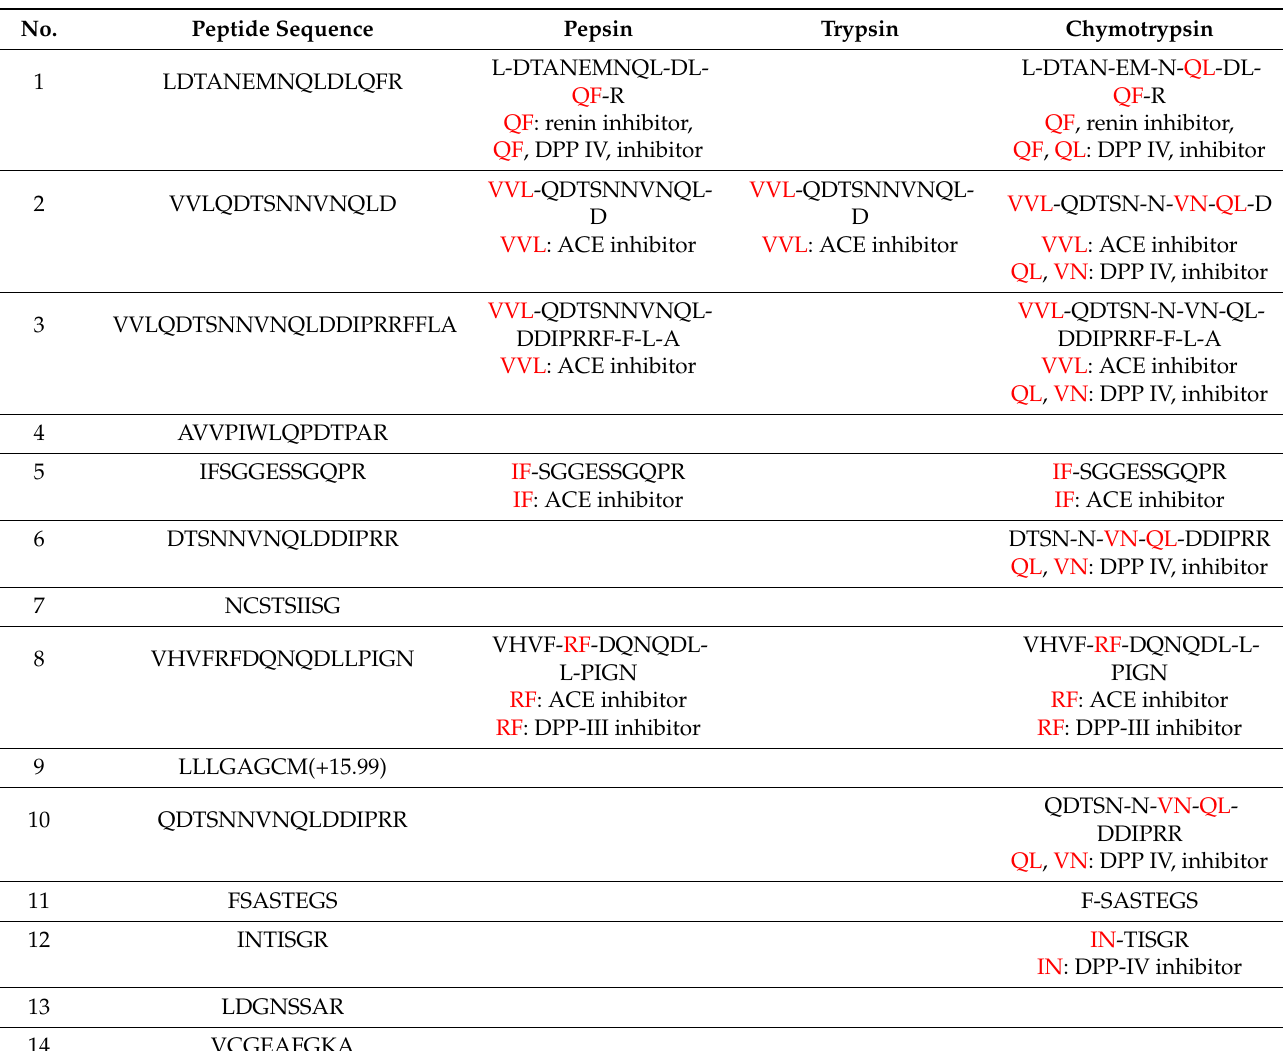
Table 6. Molecular species (predicted) produced by the proteolytic activity of main digestive enzymes acting on peptides identified by Peaks DB and by PEAKS de novo sequencing: ACE, angiotensin con- verting enzyme; DPP, dipeptidyl peptidase. Peptide fragments with previously reported bioactivity are shown in